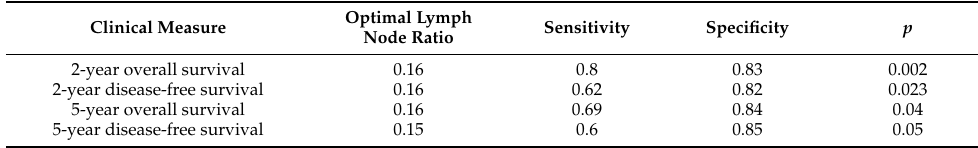
Table 4. Lymph node ratio sensitivity and